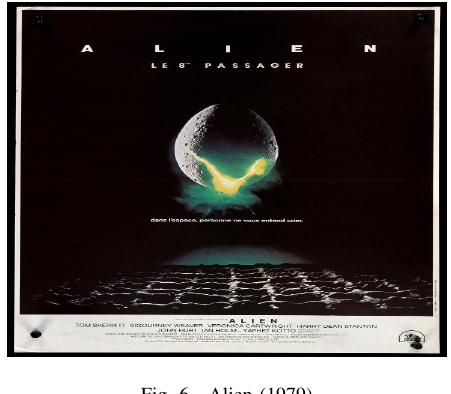
Fig. 6. Alien (1979)